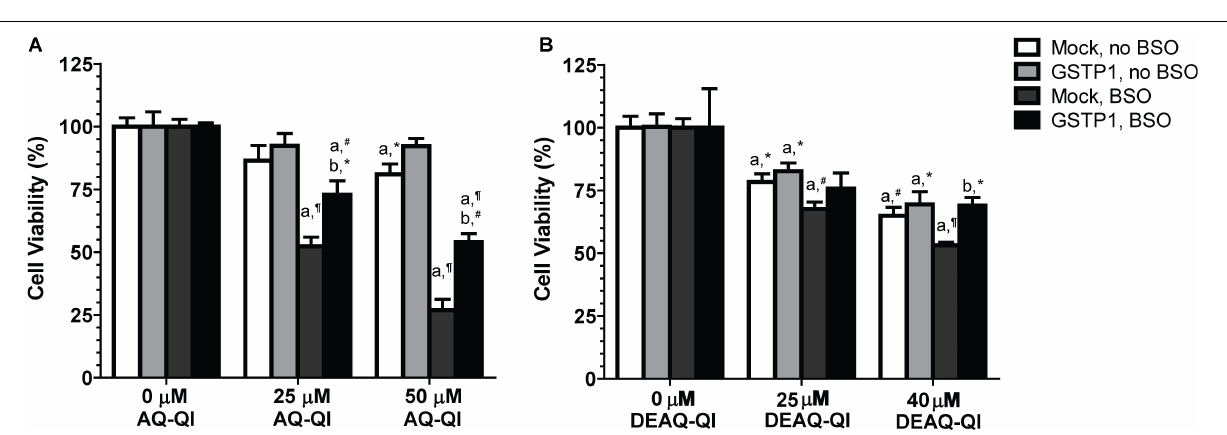
FIGURE 2 | Fitted dose–response curves of viability of HepG2 cells under treatment of AQ or AQ-QI (A) and DEAQ or DEAQ-QI (B) . HepG2 cells were exposed to test compounds for 2.5 h. GSH depletion was performed by addition of BSO (500 µ M) 24 h before the exposure. Cells were recovered overnight and cell viability was measured by resazurin reduction activity. Results are presented as percentage relative to vehicle controls in respective treatment groups. Each data point represents the mean ± SD ( n = 3).